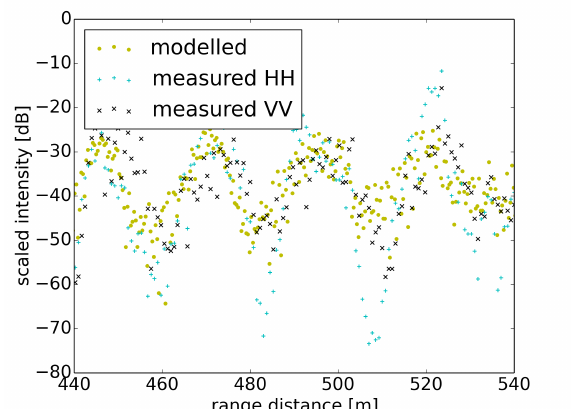
Figure 6. Measured HH and VV and modelled backscatter intensity averaged along 10 neighbouring azimuth lines. The modelled intensity is scaled to match the order of magnitude of the measured